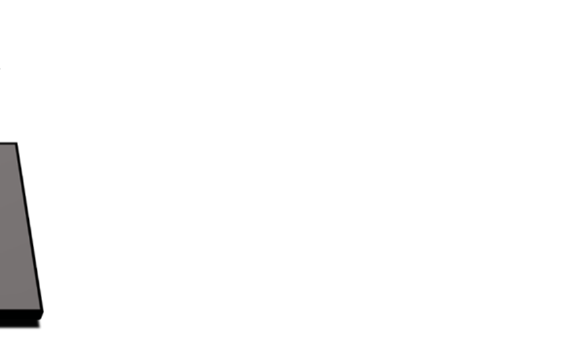
Figure 1. A schematic of a performed FSP process. In this figure, the rotating pin is plunging into a singular area of the working piece.